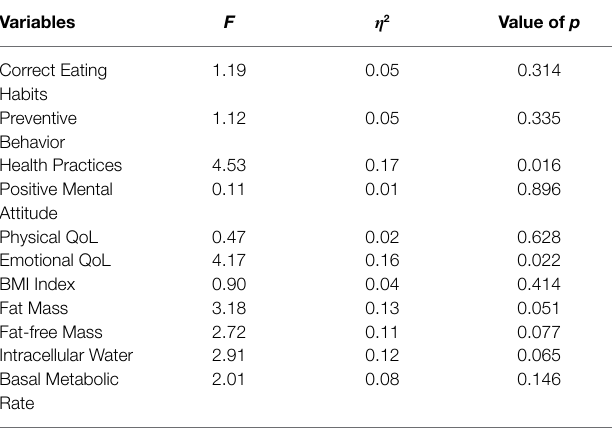
TABLE 4 | Statistical tests of interaction effects between cluster membership and the change from the first to the second measurement. Variables F η 2 Value of p